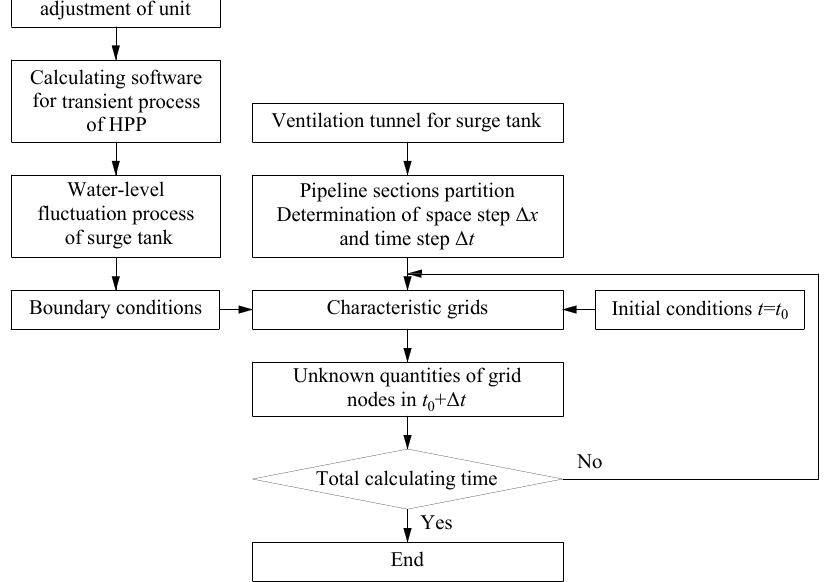
Figure 5. The complete simulation process of the wind speed in the ventilation tunnel for the case of a surge tank during a transient process.